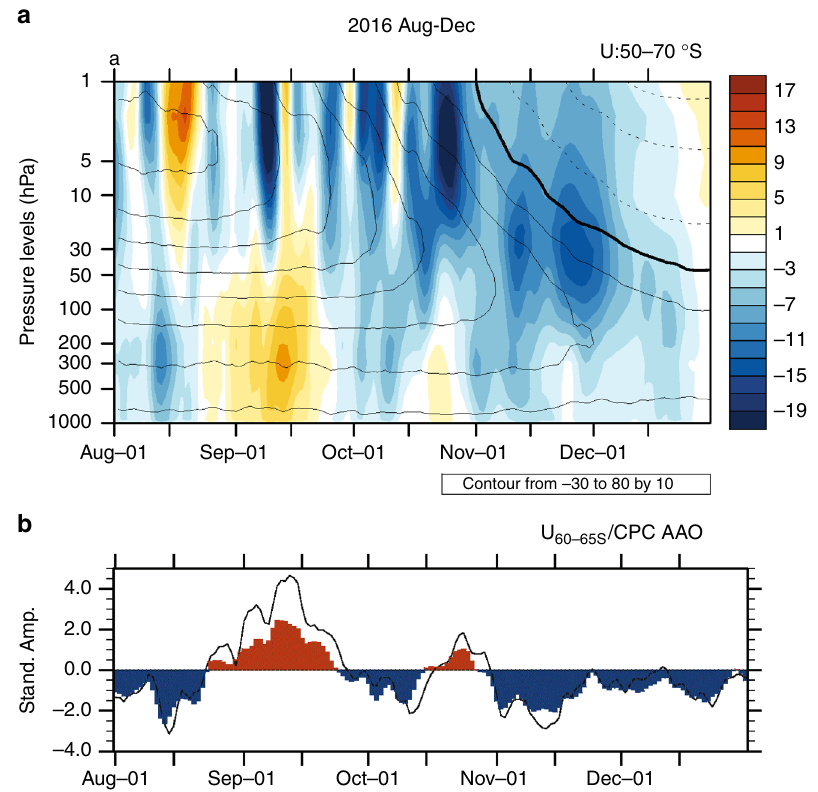
Fig. 4 Daily anomalies of Antarctic circulation in August to December 2016. a Zonal mean zonal wind anomalies averaged 50 – 70 ˚ S (shading, m s − 1 ) superimposed with climatological zonal mean zonal wind (contour interval 10 m s − 1 , easterly values dashed, and zero contour thickened). b Standardised amplitudes of the daily U 60 – 65S index (shading) and the NOAA CPC Antarctic Oscillation index that represents SAM (curve). Plots were generated using the NCAR Command Language version 6.4.0